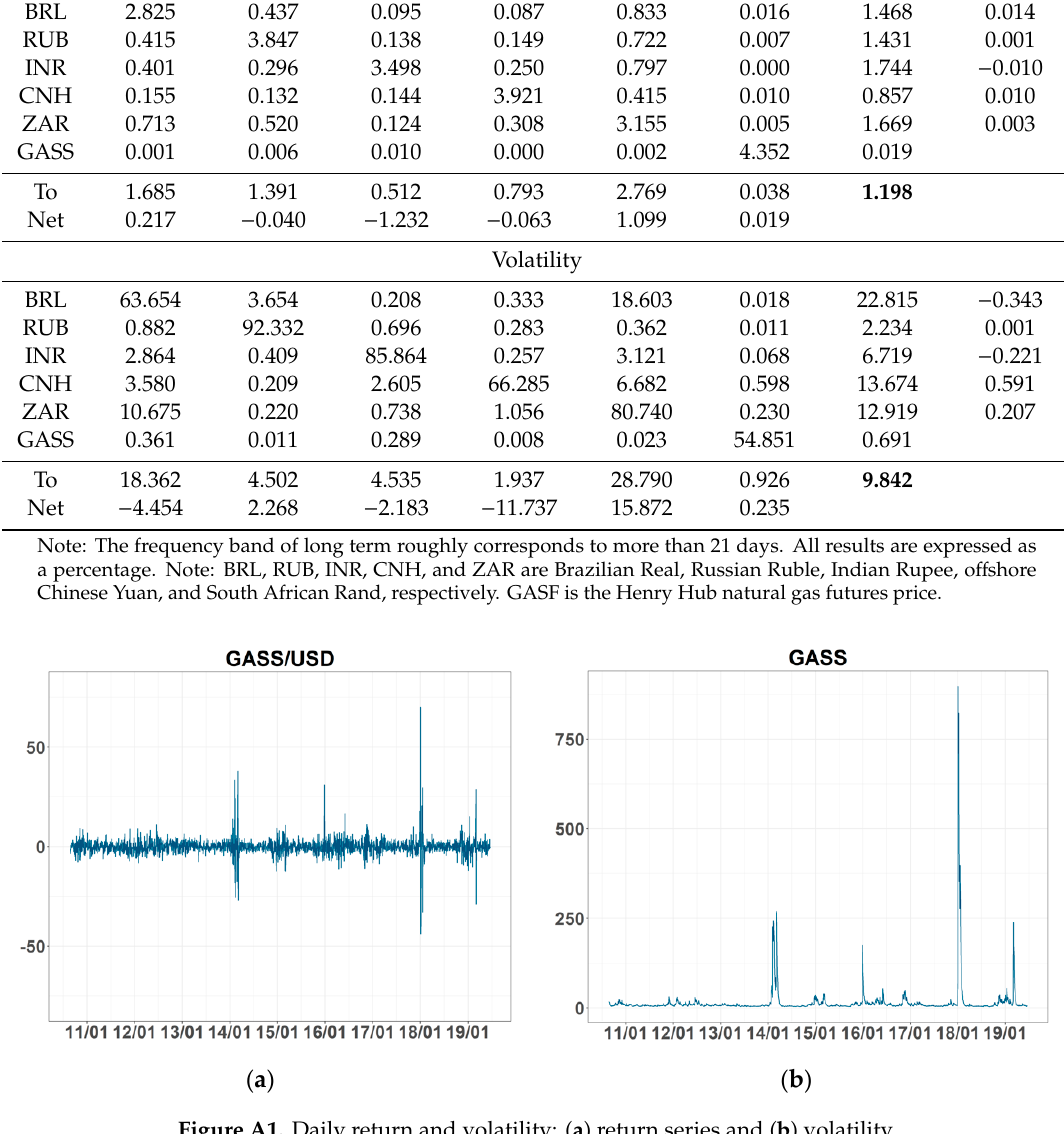
Figure A2. Dynamic connectedness: ( a ) total connectedness of return series and ( b ) total connectedness of volatilities. Note: BRL, RUB, INR, CNH, and ZAR are Brazilian Real, Russian Ruble, Indian Rupee, offshore Chinese Yuan, and South African Rand, respectively. GASF is the Henry Hub natural gas futures price. ( a ) ( b ) Figure A3. Frequency decomposition of dynamic connectedness: ( a ) frequency decomposition of total connectedness for return series and ( b ) frequency decomposition of total connectedness for